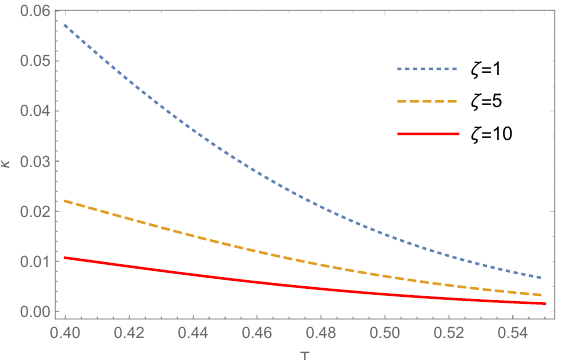
Figure 11 . The dependence of the transition rate of the Hawking-Page phase transition from the large SAdS black hole state to the thermal AdS state on the ensemble temperature T for the exponentially decayed friction kernel. In the plot, L = 1 , γ = 1 , and ˜ ω = π